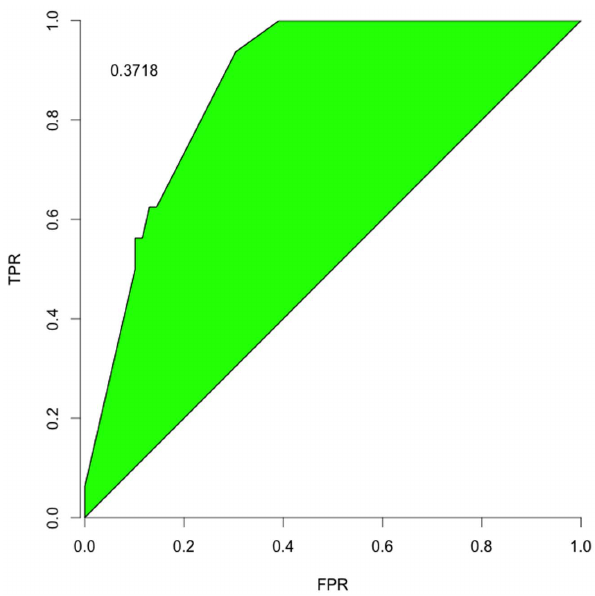
Figure 5. Activation Identification. The ROC for identifying the flexible and free activation interactions in the yeast cell network.